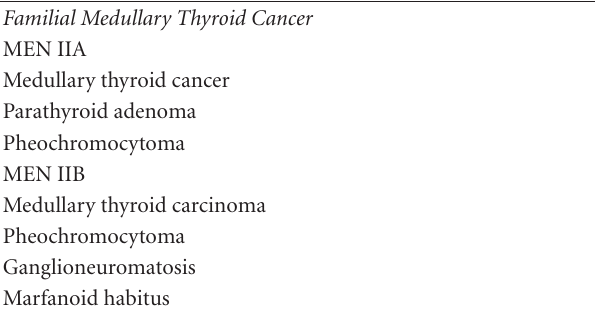
Table 5: Familial medullary thyroid